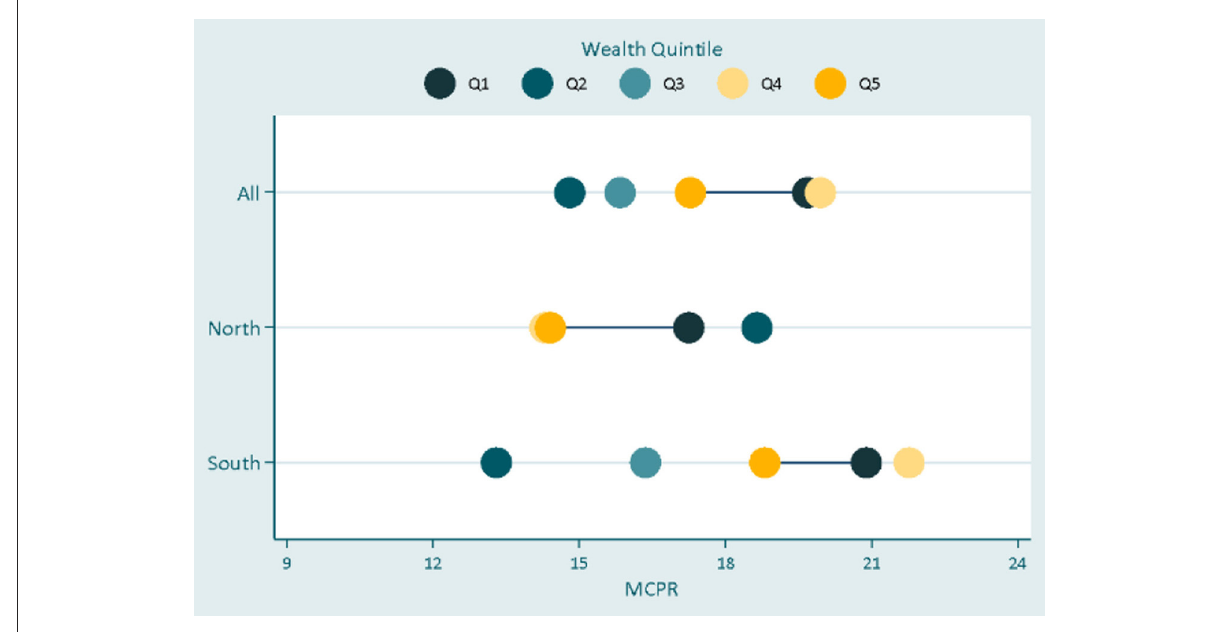
FIGURE2 Inequalities in contraceptives uptake by household wealth.